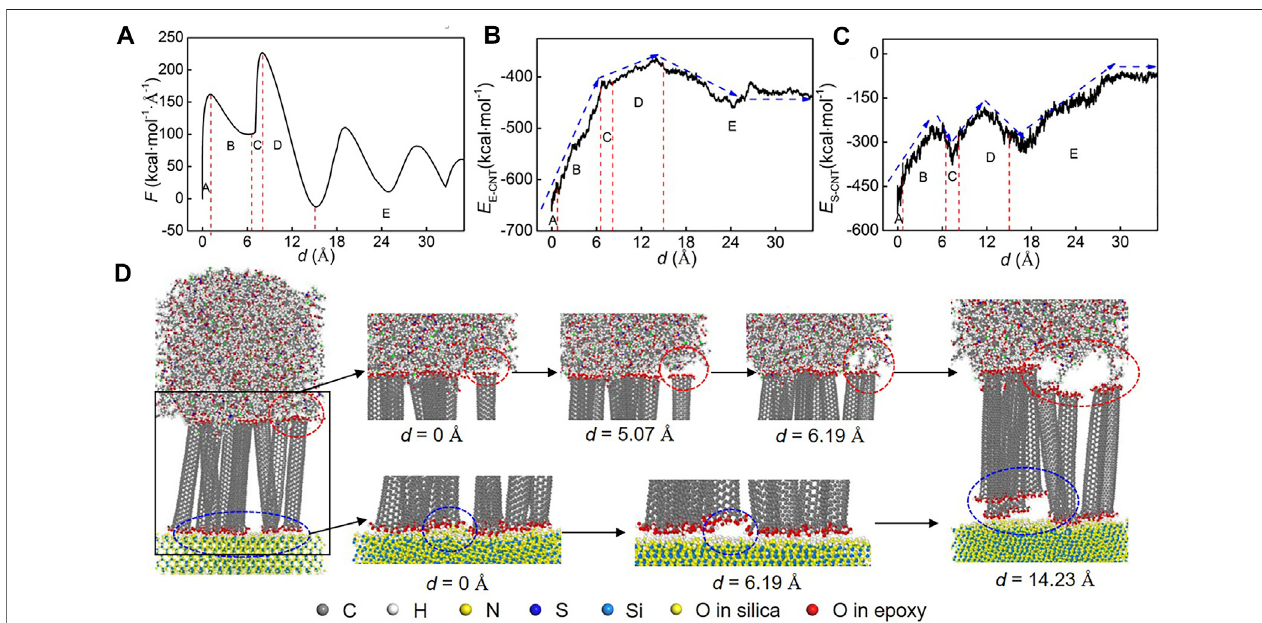
FIGURE6|(A) PullingforcecurveofthesandwichedstructurewithSWCNTcoating.ThelengthofSWCNTsisabout6.3 nm.Afterforceis fi rstreducedtothelocal minima ( d (cid:1) 6.19 Å), thereisarapidincrement. Thisisbecauseofthemechanicalinterlocking causedbySWCNTs. (B) Variationofinterfacialenergy betweenepoxyand SWCNTs. E E-CNT refers to the interfacial energy between epoxy and SWCNTs. (C) Variation of interfacial energy between silica and SWCNTs. E S-CNT refers to the interfacial energy between silica and SWCNTs. (D) Structural evolution of the interface in the sandwiched system. The interface fails at the point of force close to zero ( d (cid:1) 14.23